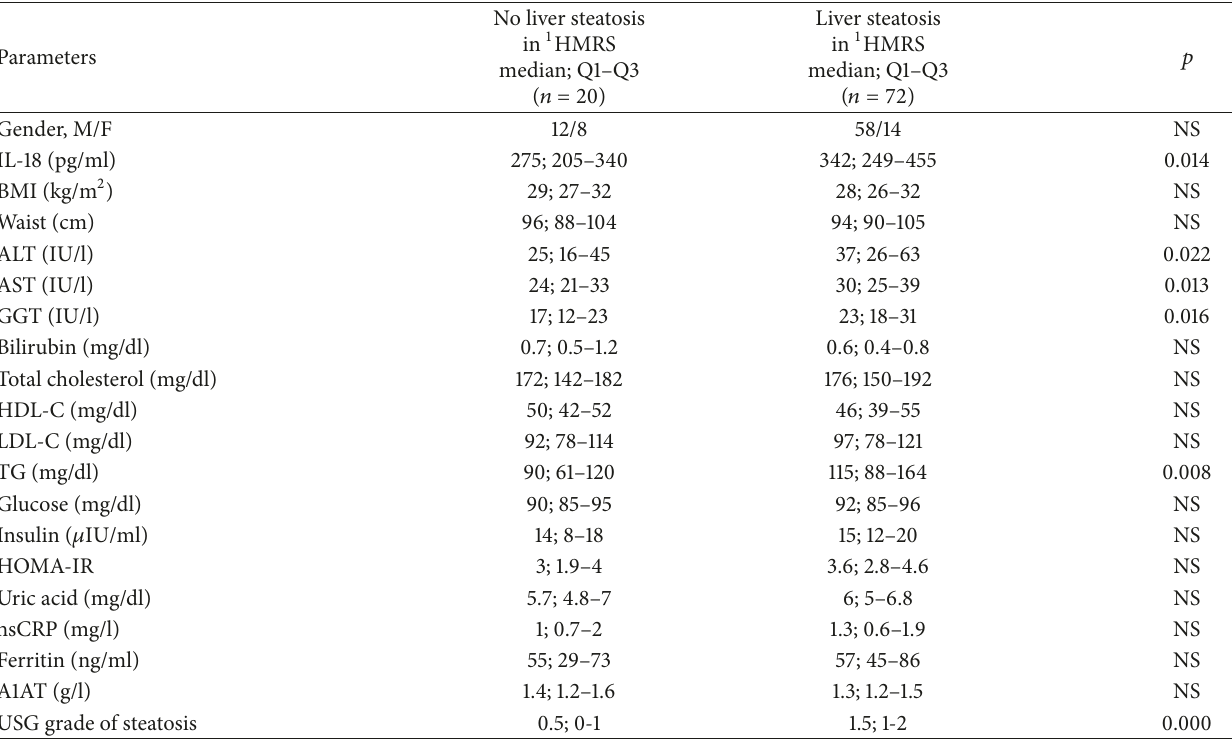
Table 4: Comparison of obese children with (𝑛 = 72) and without (𝑛 = 20) liver steatosis diagnosed with measurement of intrahepatic lipid content using 1